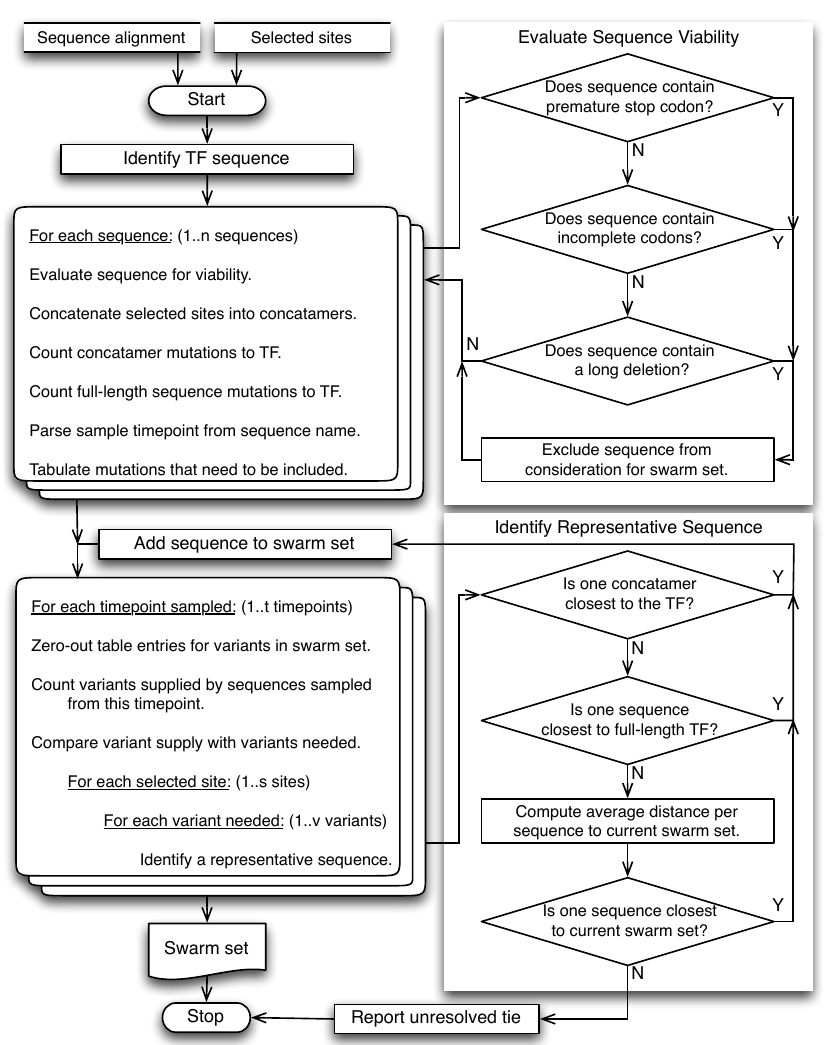
Figure 9. Swarm-selection algorithm. From a protein sequence alignment and list of selected sites, this approach identifies viable Envs and tabulates mutations in selected sites. The table initially defines which mutations will be represented by the swarm, and subsequently keeps track of which mutations remain to be included. Rare mutations, i.e. , mutations detected fewer times than the minimum variant count over the entire sampling period, are disregarded. Selection among multiple sequences that carry a mutation is resolved by minimizing a series of distance criteria, first to minimize Hamming distance (number of mutations, gaps included) to the TF form among selected sites, then distance to the full-length TF sequence, and finally to minimize average distance to sequences in the current swarm set. The selected Env is included in the swarm set, counts in the table of needed mutations are set to zero, to indicate the particular mutation is now covered in the swarm, and iteration continues. This produces a “swarm” of Envs, which represents diversity in selected sites as it developed within the subject, given sampling constraints. Stacked boxes signify iteration. Unresolved ties are reported, though we have not yet encountered them in several large experimental sequence sets we have tested; such an outcome would signal the need for an alternative distance metric or more selection